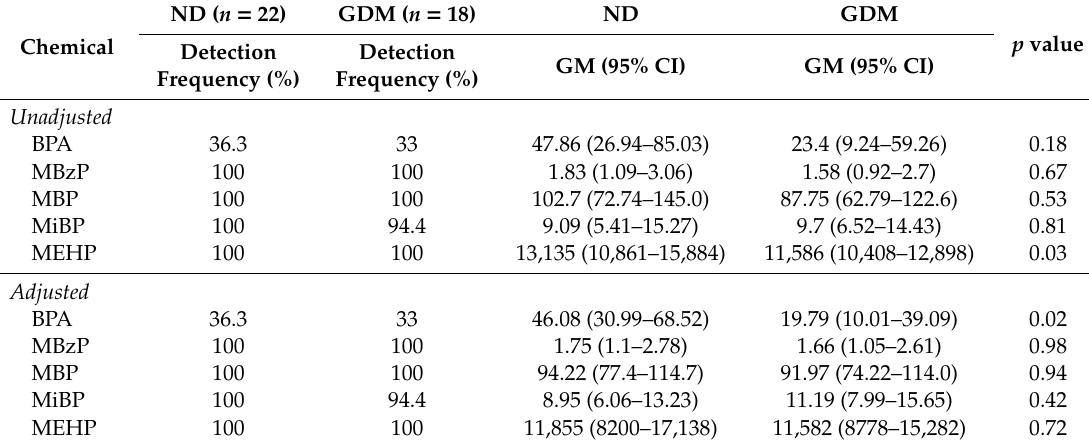
Table 3. Urinary concentrations of unadjusted ( µ g / L) and adjusted total BPA and phthalates metabolites ( µ g / g Cr) by